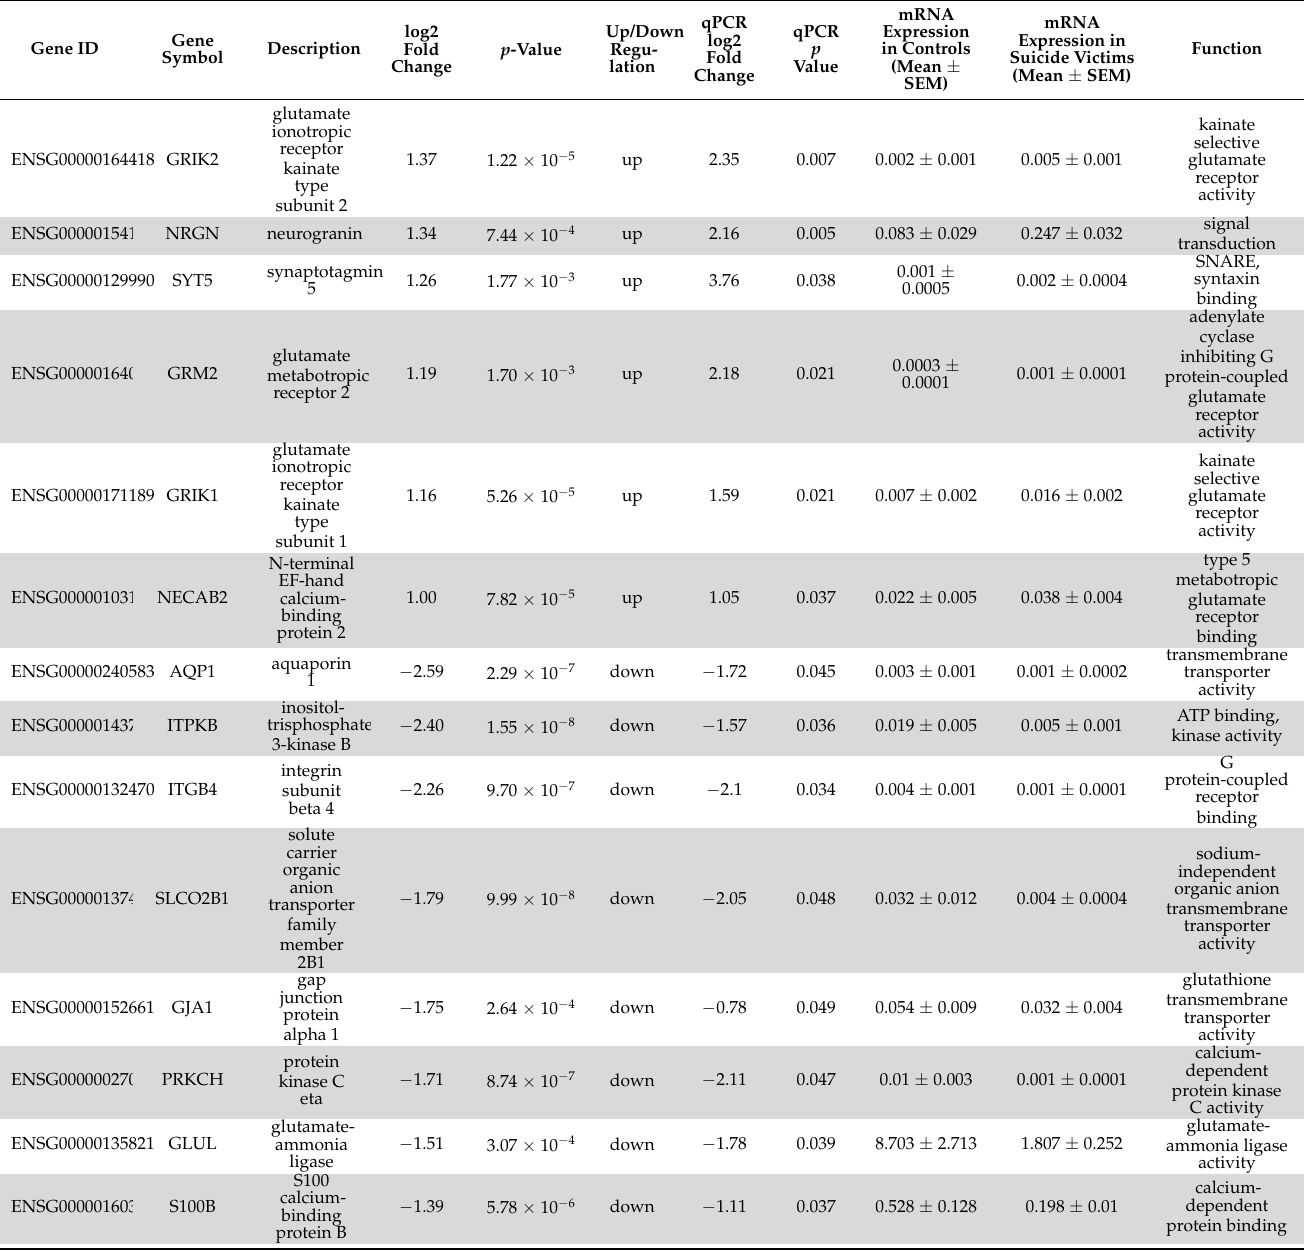
The genes are arranged according to their fold-change values